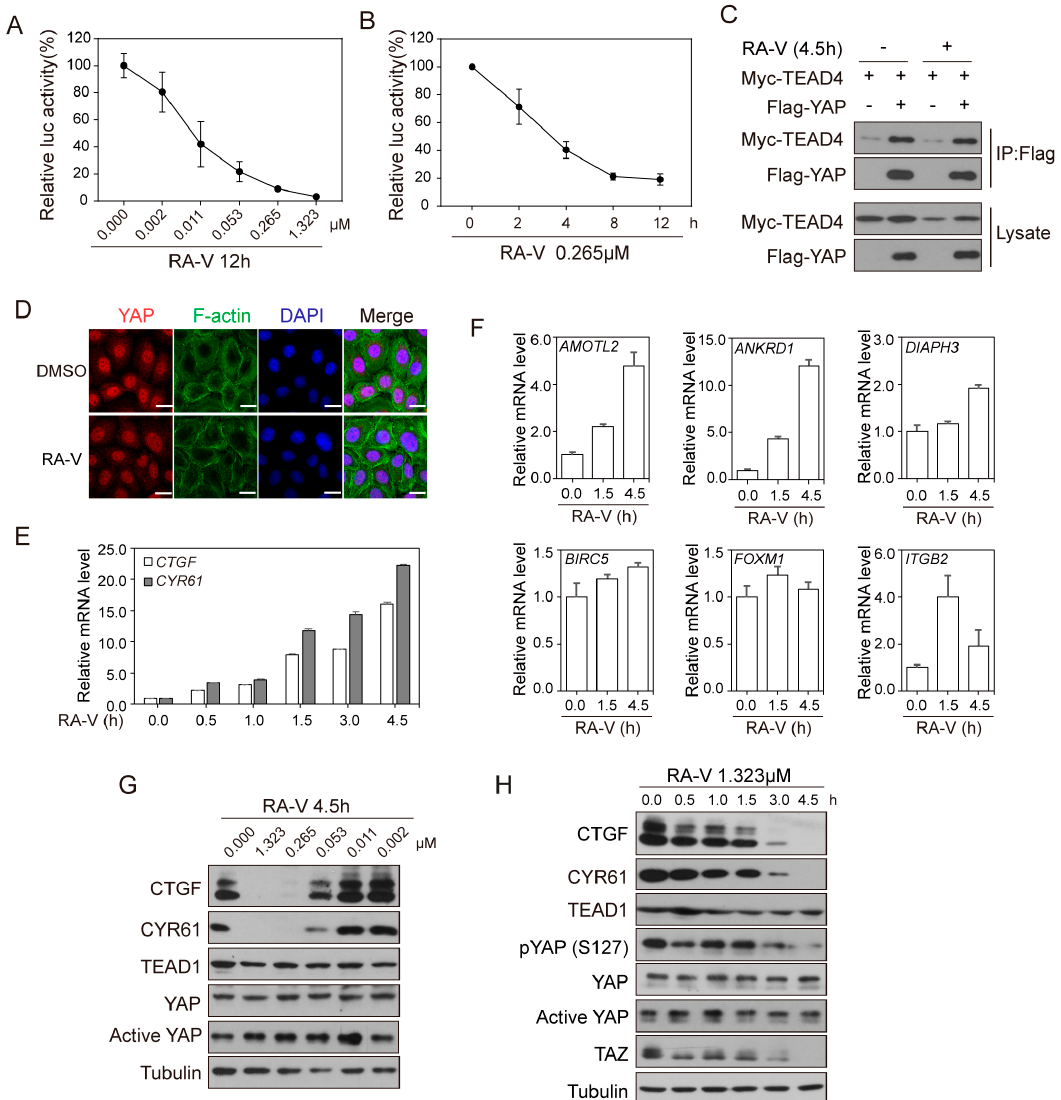
Figure 2. RA-V represses the protein levels but not mRNA levels of YAP target genes. ( A , B ) RA-V inhibits YAP reporter activity in a dose-(A) and time-dependent (B) manner. HEK293T cells were transfected with YAP, Gal4-TEAD4, 9 × UAS-luciferase, β -galactosidase and treated as the indicated. Luciferase activities were then measured and normalized to β -galactosidase activities. ( C ) RA-V does not affect YAP–TEAD interaction. HEK293A cells were transfected as indicated and treated with DMSO or RA-V at 0.265 μ M for 4.5 h before harvest. Cell lysates were immunoprecipitated with anti-Flag antibody and examined by western blotting. The beads had a low-level non-specific binding of Myc-TEAD4. ( D ) RA-V does not affect YAP subcellular localization. HeLa cells were trypsinized and attached again in the presence of DMSO or RA-V at 0.265 μ M for 4.5 h. Cells were then subjected to immunofluorescence staining. Scale bars, 20 μ m. ( E , F ) RA-V induces mRNA expression of canonical YAP target genes CTGF and CYR61 (E) as well as several other genes (F). HEK293A cells were trypsinized and attached again in the presence of DMSO or 1.323 μ M RA-V for the indicated time. mRNA was extracted and gene expression levels were determined by quantitative RT-PCR. ( G , H ) The protein levels of CTGF and CYR61 were inhibited by RA-V in a dose-(G) and time-dependent (H) manner. HeLa and HEK293A cells were trypsinized and attached again for 4.5 h in the presence of DMSO or RA-V. Cells were then lysed and examined by western blotting. Values represent mean ± SD from three technical repeats.